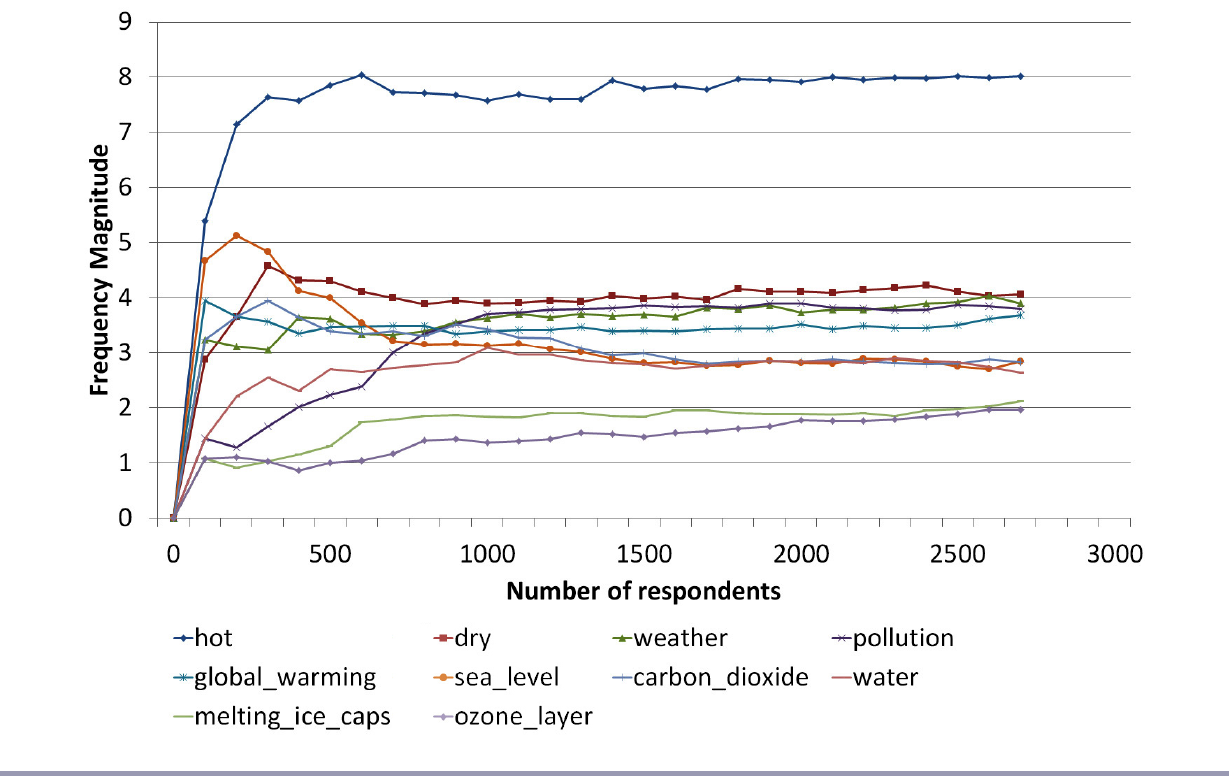
Fig. 2. Split profile of the 10 most frequently occurring word categories associated with climate change for three respondent groups: scientists/academics/researchers, government employees, and community members. Categories are ordered by frequency magnitude across all three